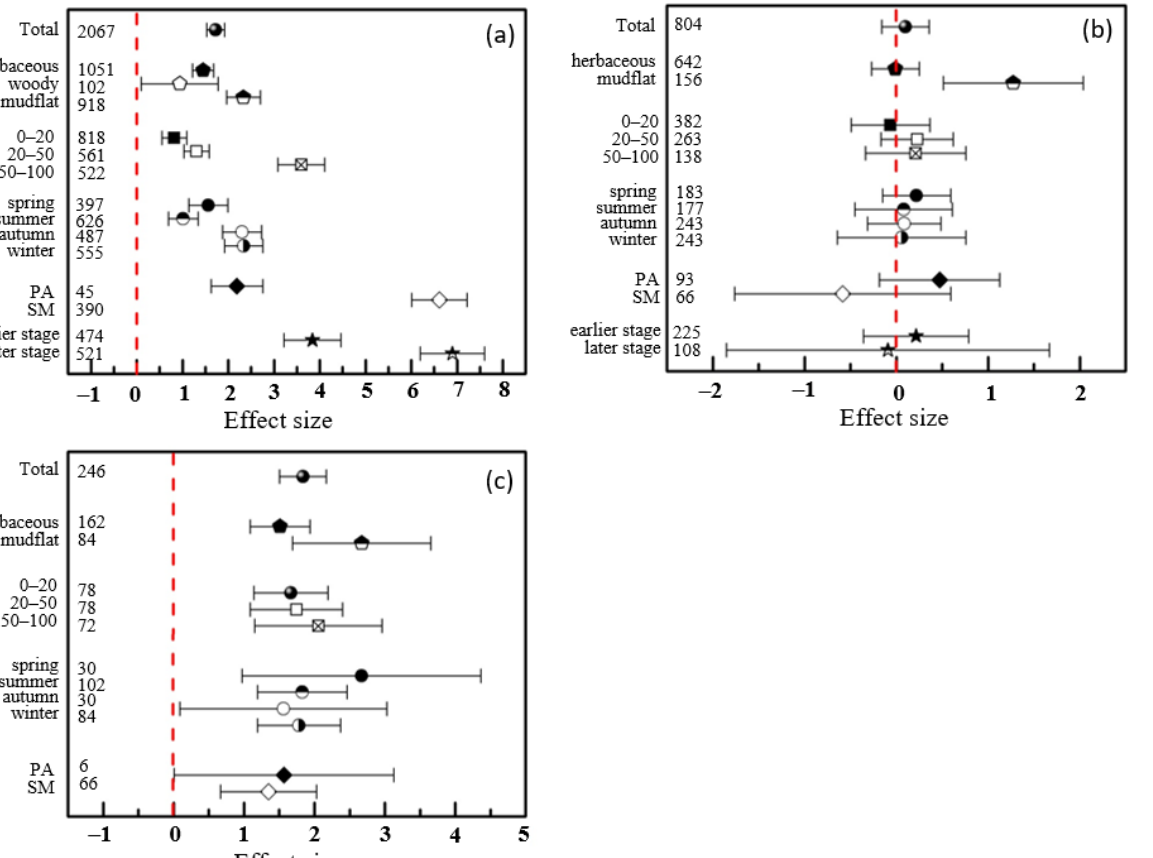
Figure 3. Effects of impacts of S. alterniflora invasion on soil total sulfur ( a ), sulfate ( b ), and sulfide ( c ) contents. The vertical line was drawn at SMD = 0.